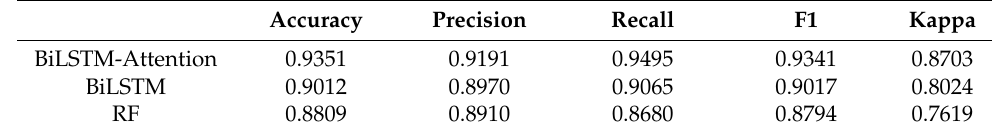
Table 2. Accuracy analysis of different methods.